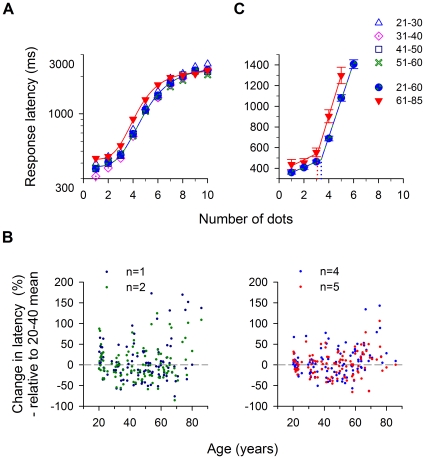
Response latency.(a) Mean response latency as a function of the number of dots. The data of the four younger groups (20–60-yr-old) were combined as shown by a blue curve. For the range of 1 to 6 dots, the latency of the older group is prolonged by 20% when compared with that of the younger group. Note that the symbol legends are listed in panel C. (b) Change in response latency. The latency data is recalculated as percentage change relative to the 20–40-yr-old group mean – positive values indicate longer latencies than the youngest age group, and vice versa. Left panel: numerosity 1 & 2 (subitizing). Right panel: numerosity 4 & 5 (counting). (c) Determination of subitizing span. A bi-linear function was used to fit the mean response latency data, with the intersection point representing the subitizing range. The subitizing speed (the slope before the intersection point) and counting speed (the slope after the intersection point) are both slowed down by 10% in older observers.